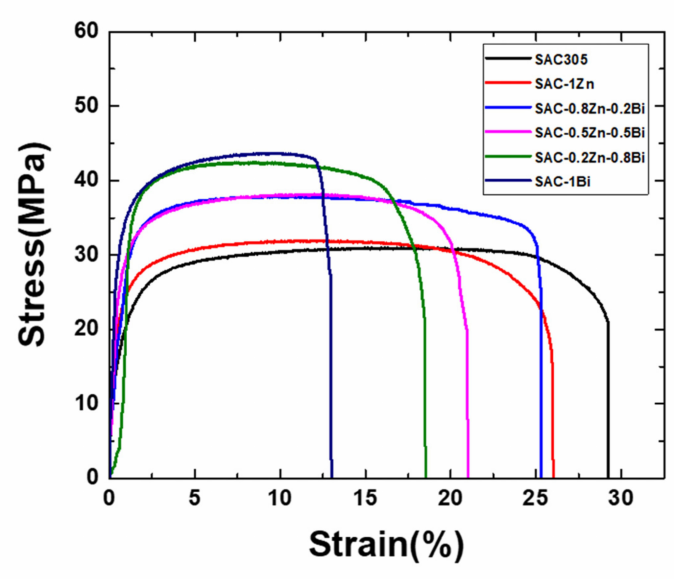
Figure 1. Stress-Strain Curve results according to